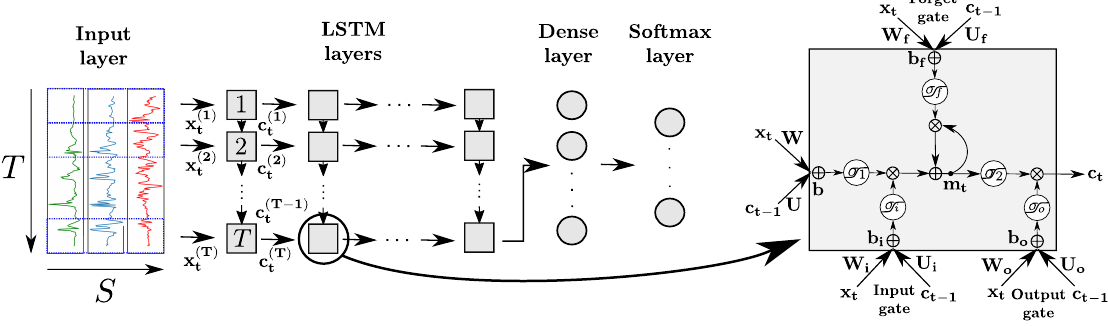
Figure 5. Architecture of a LSTM network for sensor-based HAR (left). The intermediate and last LSTM layers are organized in a many-to-many and many-to-one layout, respectively. Each LSTM layer is composed of LSTM cells (right). x t , m t and c t represent the cell input, memory, and output at time t , respectively. In addition, (cid:76) and (cid:78) refer to the element-wise addition and multiplication, respectively. W ∗ , U ∗ , b ∗ and σ ∗ designate internal weight matrices, bias vector and activation function (for gate ∗ ∈ { i , o , f } ). σ 1 and σ 2 are internal activation functions applied on the input and memory of the cell, respectively.